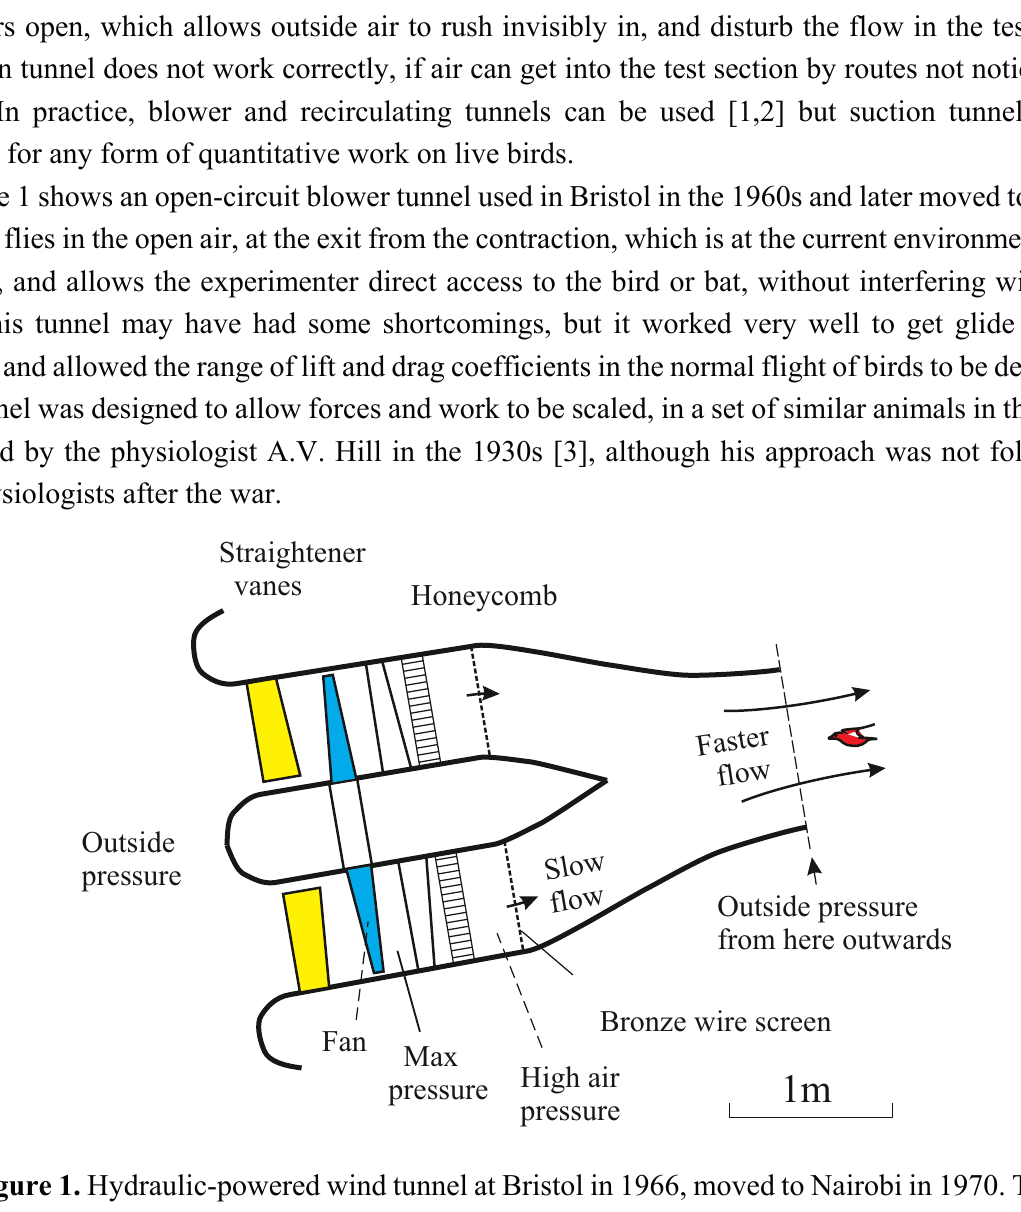
Figure 1. Hydraulic-powered wind tunnel at Bristol in 1966, moved to Nairobi in 1970. This tunnel was powered by a Woods ventilating fan, with a contraction ratio of about 4. Fixed stator vanes before and after the fan straightened the flow, and there was a honeycomb and a fine mesh screen before the contraction. The pigeon flew outside the end of the contraction, where it could be photographed and measured at will. Maximum speed 22.1